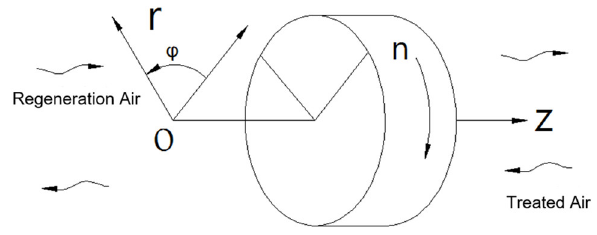
Figure 2. Schematic diagram of the mathematical model of the rotor.